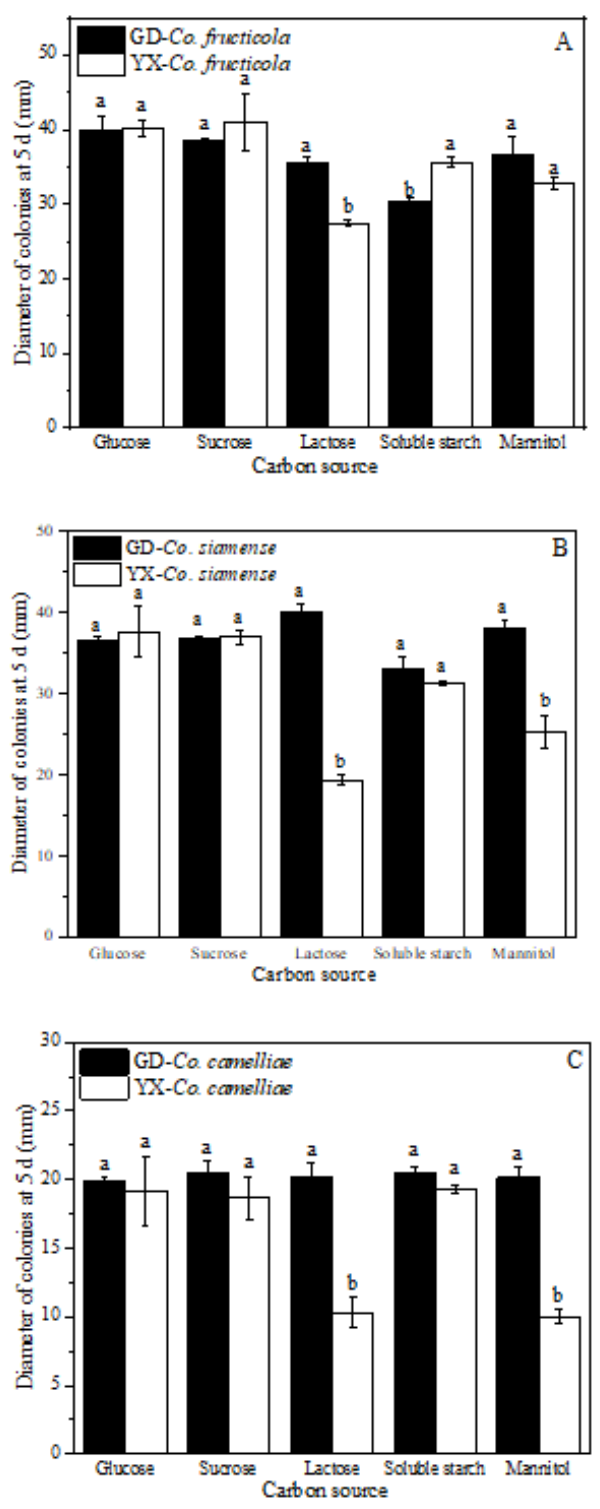
Figure 8. Effect of carbon sources on the growth of ( A ) YX- Co . fructicola (YX2-5-2) and GD- Co . fructicola ; ( B ) YX- Co . siamense (2YX-8-1-1) and GD- Co . siamense ; ( C ) YX- Co . camelliae (2YX-5-1) and GD- Co . camelliae . The error bars represent standard deviations based on three biological replicates. Diameters of colonies followed by the same lowercase letter are not significantly different at p < 0.05 using an ANOVA.